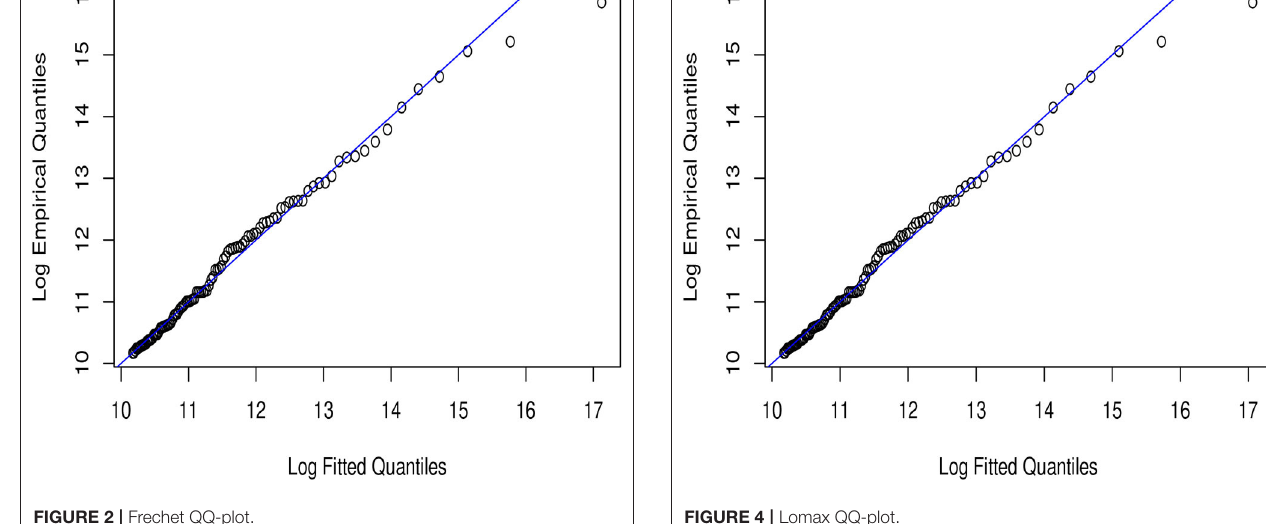
FIGURE 4 | Lomax QQ-plot.